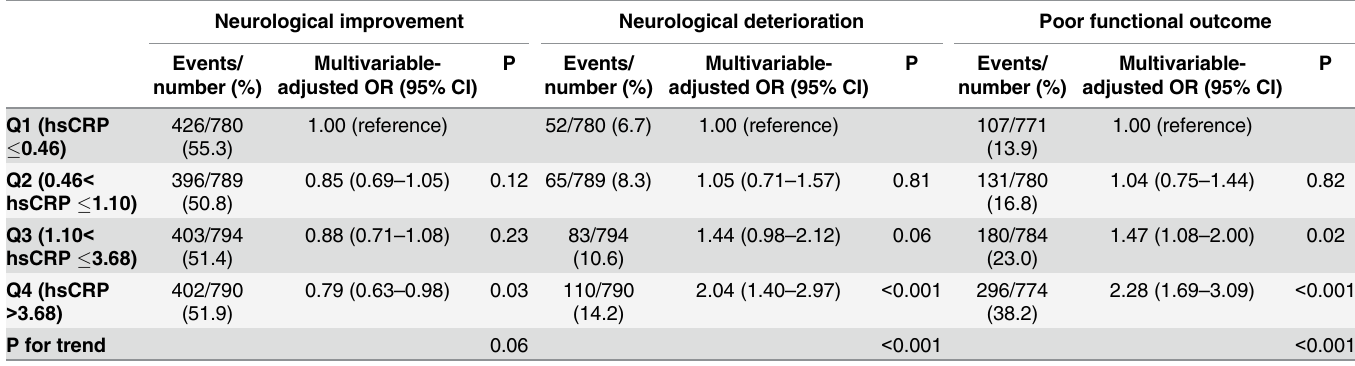
Table 5. Plasma hsCRP levels and clinical outcomes in patients without post-stroke acute